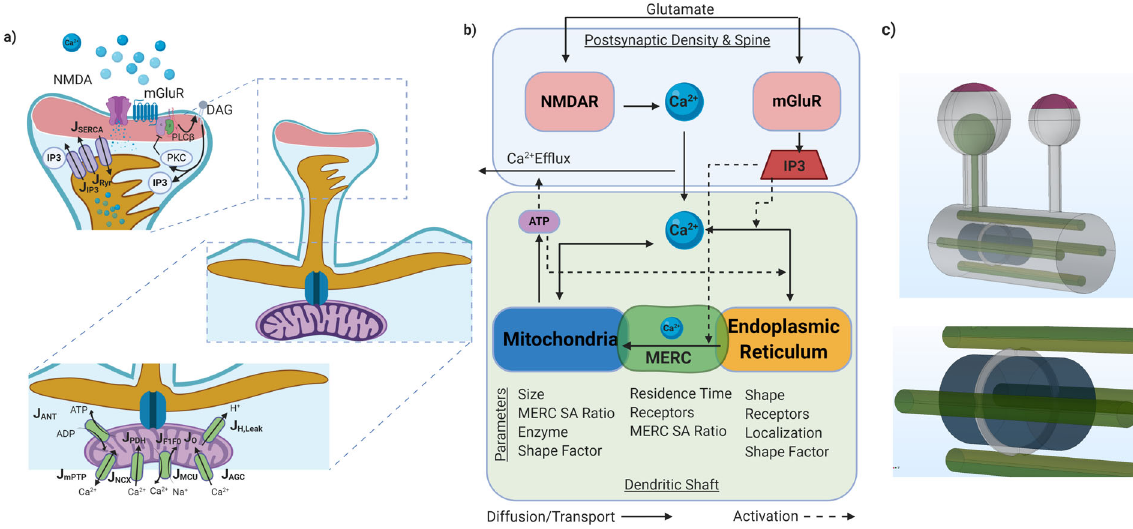
Fig. 1 Schematic of the model architecture and fl uxes in each compartment. a Glutamatergic signaling in a postsynaptic spine leads to an in fl ux of Ca 2 + from the extracellular space and from the endoplasmic reticulum. Dynamics of Ca 2 + have a direct impact on mitochondrial function that alters ATP production 27,30 . The main fl uxes involved in the model are shown here and the mathematical descriptions are given in Supplementary Table 2. b The main compartments and investigated parameters in the model are shown in this schematic. In this fi gure, solid lines represent diffusive or transport fl uxes. Dashed lines represent an activation of fl uxes. c Model geometry for a dendritic spine developed using COMSOL Multiphysics. Two spines, one with and one with the spine apparatus are connected by a dendritic shaft containing the ER and mitochondria. PSD, Purple; ER, Green; MERC, Gray; Mitochondria, Blue. SA Ratio refers to the ratio of the surface area of MERCs to total mitochondria surface area ( a and b ) were created using